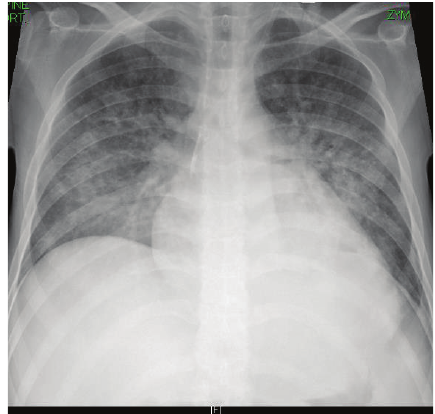
Figure 2: Portable CXR showing bilateral perihilar